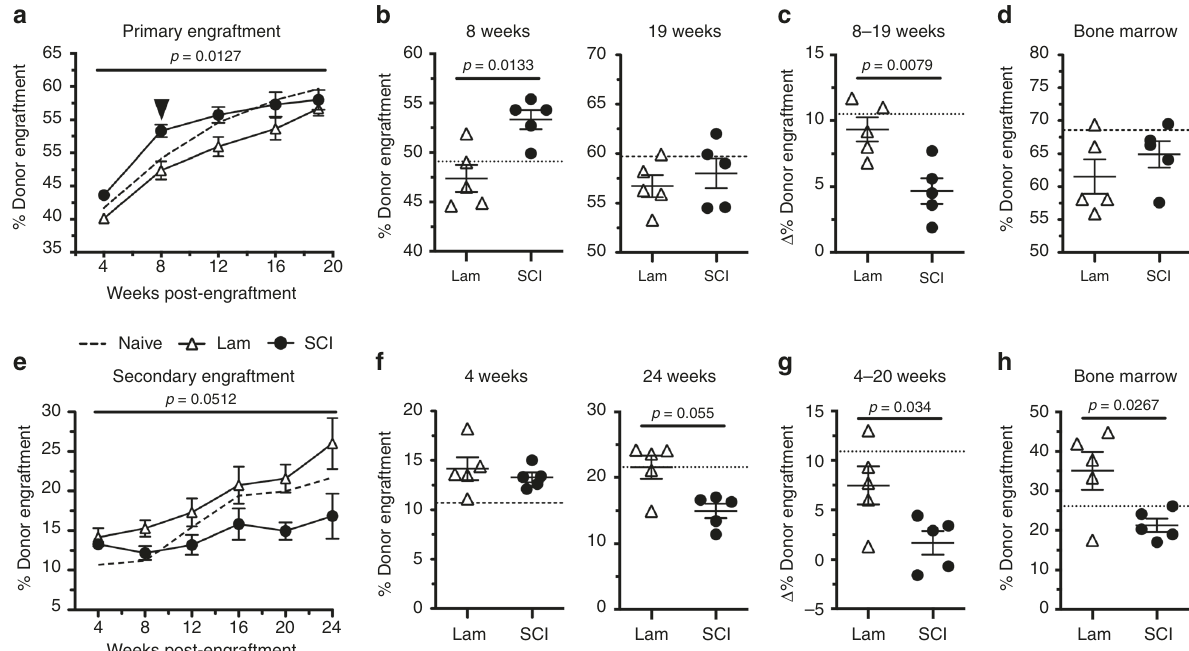
Fig. 8 T3 transection SCI impairs the long-term clonogenic potential of bone marrow by 3 dpi. a Percent donor engraftment in recipient BoyJ mice 4 – 19 weeks after primary transplantation with 3 dpi bone marrow from naïve, sham-injured (Lam), and T3 transection SCI mice. b Percent donor engraftment after primary CRU assay at the 8- and 19-week timepoints from a . c Change in percent donor engraftment from 8 to 19 weeks post- transplantation. d Percent donor engraftment in bone marrow of recipient BoyJ mice 19 weeks after primary transplantation. e Percent donor engraftment in recipient BoyJ mice 4 – 20 weeks after secondary transplantation with bone marrow from primary CRU mice. f Percent donor engraftment after primary CRU assay at the 4- and 20-week timepoints from d . g Change in percent donor engraftment from 4 to 20 weeks post-transplantation. h Percent donor engraftment in bone marrow of recipient BoyJ mice 25 weeks after secondary transplantation. All data are mean ± SEM, two-way ANOVA with repeated measures followed by Bonferroni multiple comparisons ( a , b , e , f ), two-sample t -test ( c , d , g , h ); n = 5/group in a – h ; dotted lines represent averaged data from naïve mice. Source data are provided as a Source Data fi